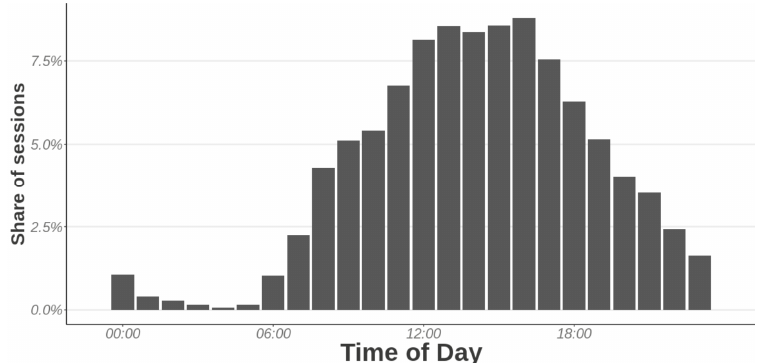
Figure 2. Distribution of fast charging sessions across the